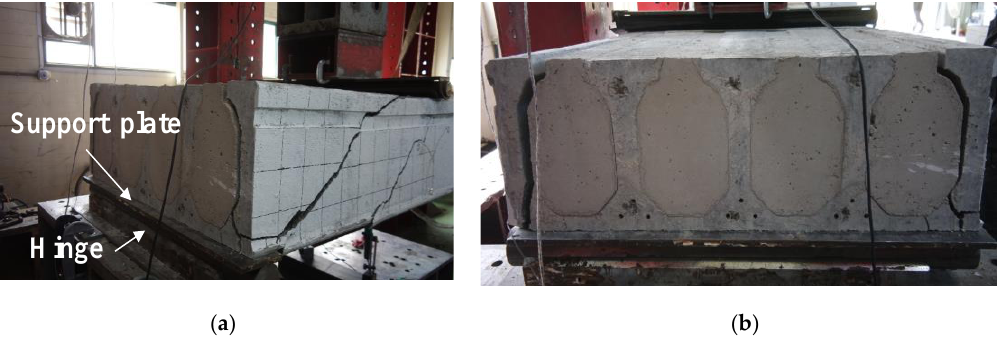
V : Shear force at flexural cracking. ** The ratio between shear strength of the strengthened f specimen and the average strength of both ends of the reference specimen NR-0/4 (341 kN).